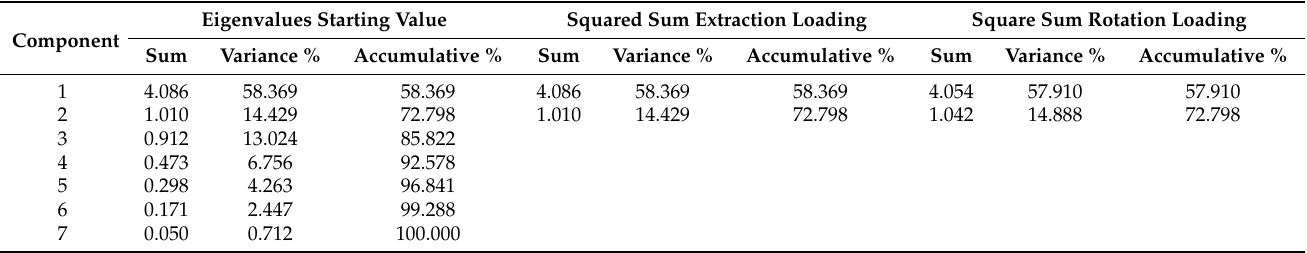
Table 7. Total interpretation